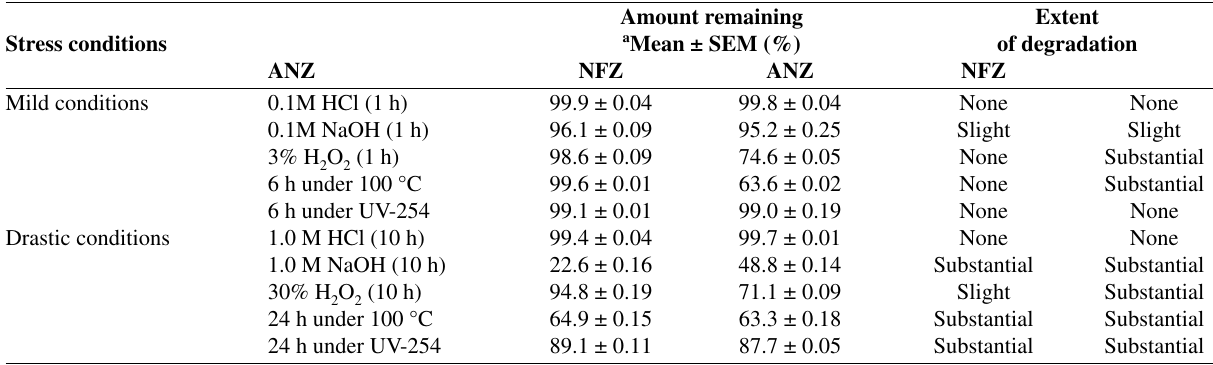
Table 6. Forced degradation results of ANZ and NFZ by UHPLC Amount remaining Extent Stress conditions a Mean ± SEM (%)